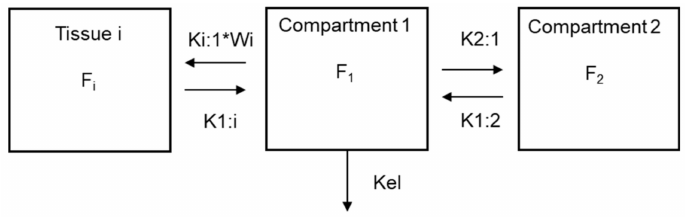
Figure A1. Multiple compartment mathematical